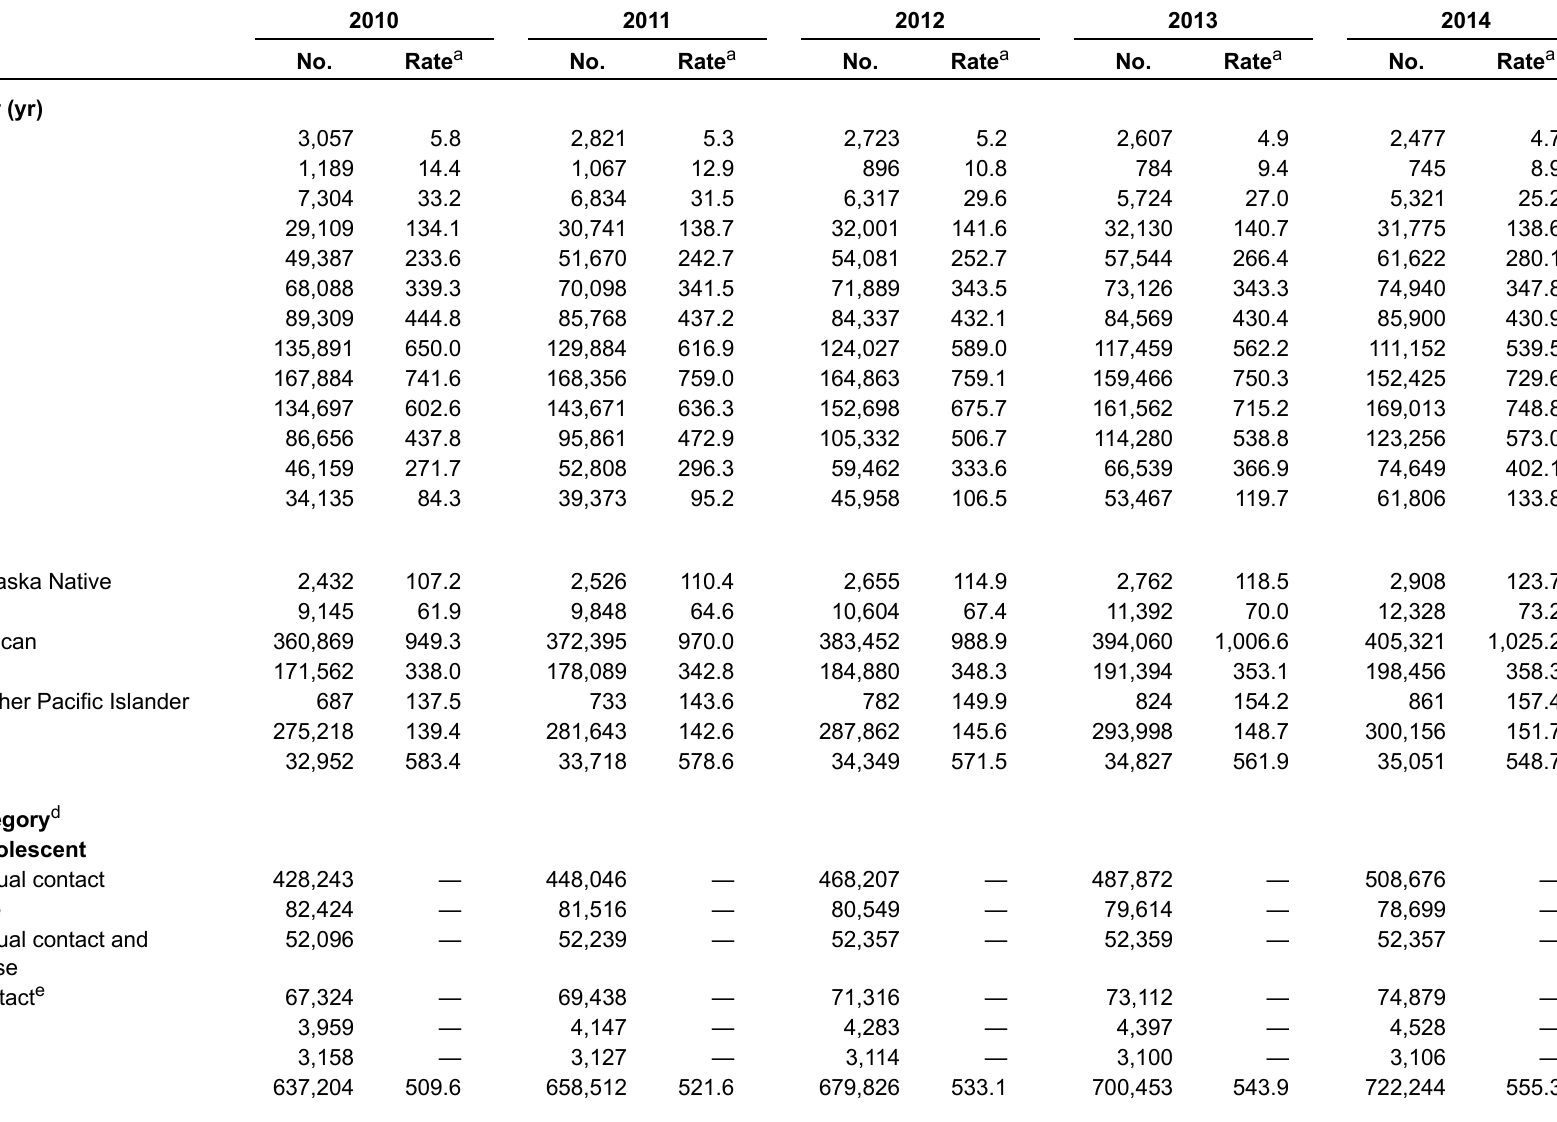
Table 18a. Persons living with diagnosed HIV infection, by year and selected characteristics, 2010–2014—United